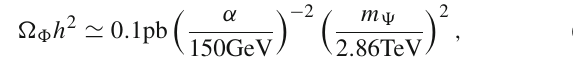
Fig. 4 Allowed region in the m Z (cid:2) − g X plane consistent with the constraint arising from B 0 Here we fix the couplings of the flavor violating neutral Yukawa interactions as 2 × 10 − 4 and 10 − 3 for the left and right plots, respectively